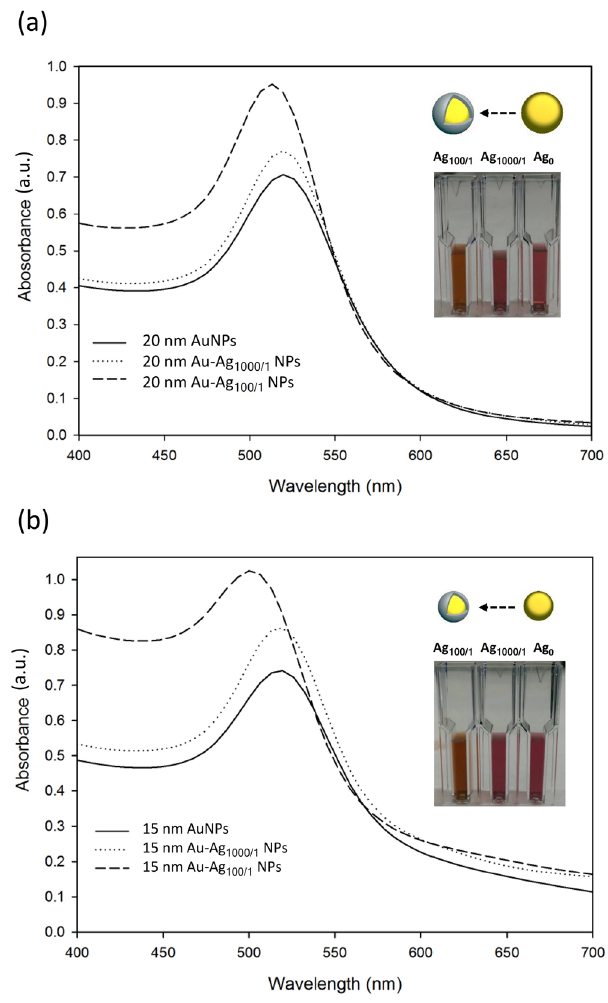
Figure 2. UV-Vis absorption spectra of different diameter Au and Au-Ag NPs. The plot shows the ( a ) 20 nm and ( b ) 15 nm Au and Au-Ag NPs at different ratios of Ag enhancement. The inset images show the solution color change after the Ag enhancement